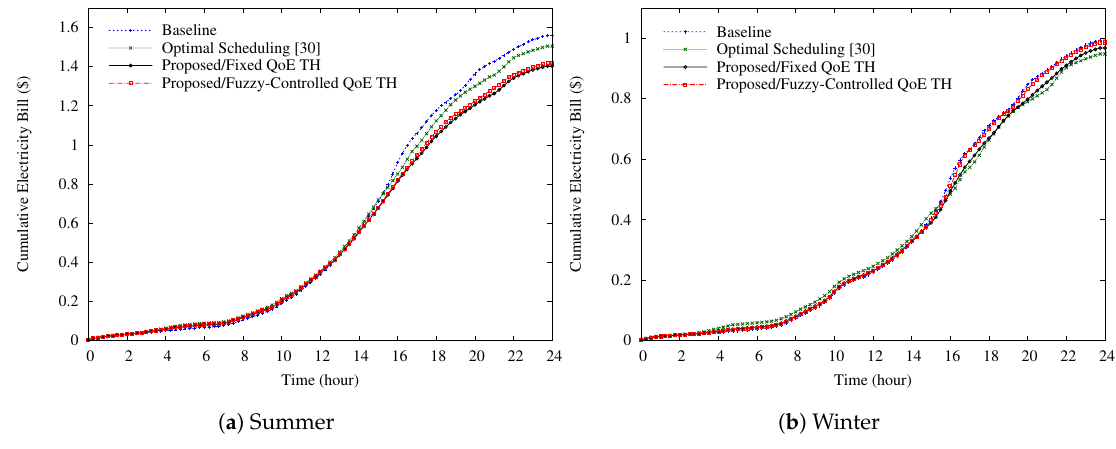
Figure 9. Comparison of the electricity bill.